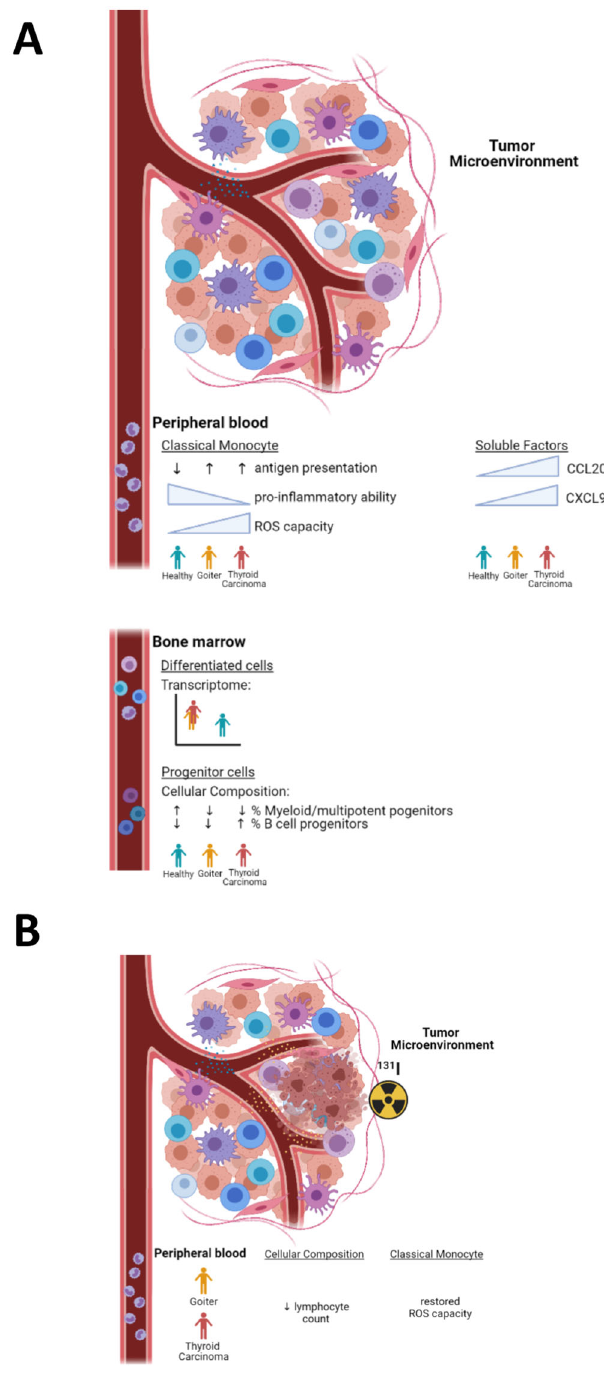
Fig. 5 | Graphical summary of main fi ndings. A Baseline. B After treatment with radioactive treatment. Created with